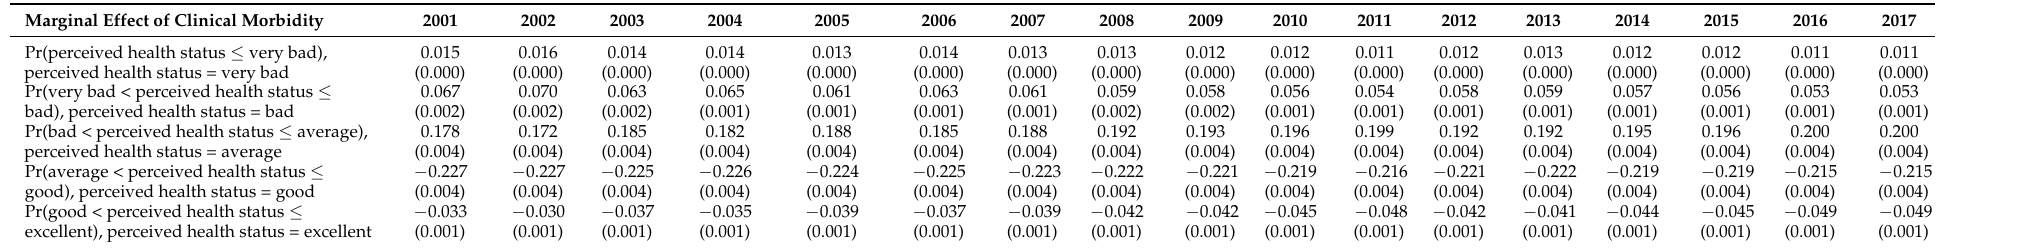
Figures in parentheses indicate standard errors. All values are significant at a p -value of ≤